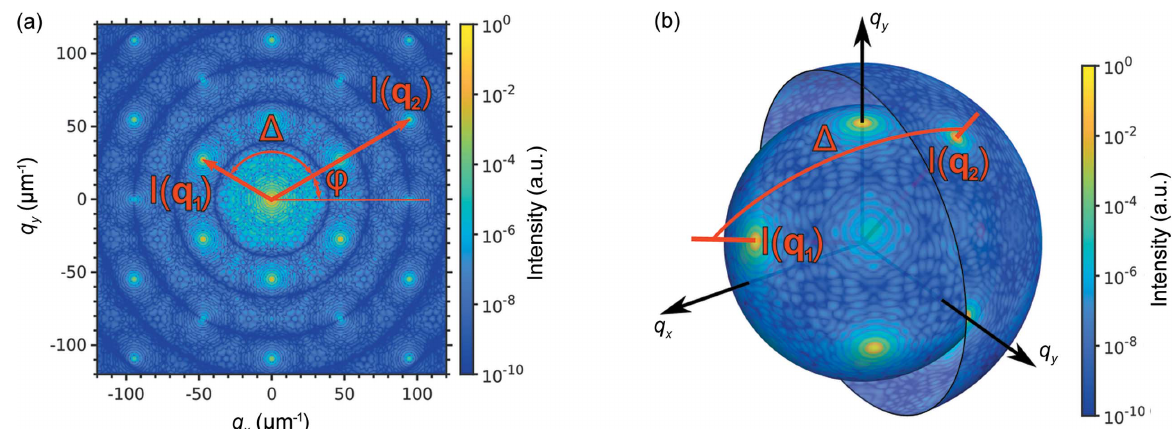
Figure 2 Scheme of the CCF calculation in the case of 2D ( a ) and 3D ( b ) intensity distributions. The product of intensities at two points q 1 and q 2 in reciprocal space, separated by the angle (cid:2) , contribute into the CCF value at this (cid:2) value. The final CCF is obtained by averaging over all points on the rings/spheres of the corresponding radii. The color code exemplarily represents the simulated intensities for a colloidal crystal with an f.c.c. structure: ( a ) 2D diffraction pattern from the colloidal crystal oriented along the [001] f.c.c. axis with respect to the incident X-ray beam and ( b ) intensities at the spheres in 3D reciprocal space of the colloidal crystal with the radii q 1 and q 2 , corresponding to the 111 and 220 reflections,